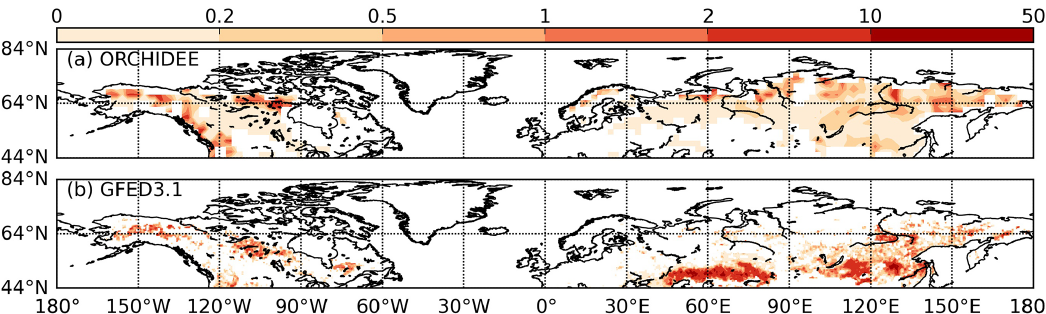
Figure 4. Mean annual burned fraction (in percent) by (a) ORCHIDEE simulation and (b) GFED3.1 data for 1997–2009. Agricultural fires are not modeled and were excluded from GFED3.1. Note the corresponding fire return intervals (FRI, in years) for different burned fraction: 0–0.2% for >500yr; 0.2–0.5% for 200–500yr; 0.5–1% for 100–200yr; 1–2% for 50–100yr; 2–10% for 10–50yr, 10–50% for 2–10yr; these are used in Fig. 8.